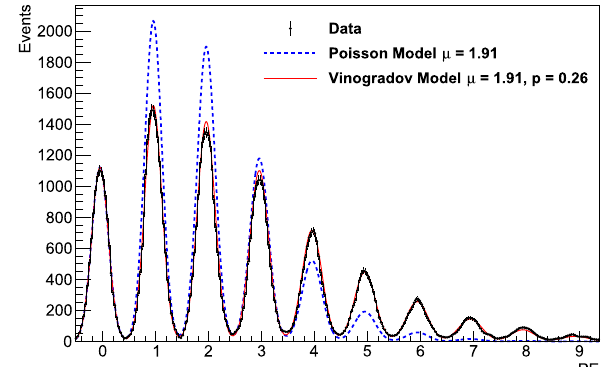
Fig. 6 A typical charge distribution, in number of photoelectrons, for a bottom channel (black histogram), superimposed with a pure Poisson modelwith μ = 1 . 91(bluedashedline)andacompoundPoissonmodel of Eq. 1 with μ = 1 . 91 and p = 0 . 26 (red solid